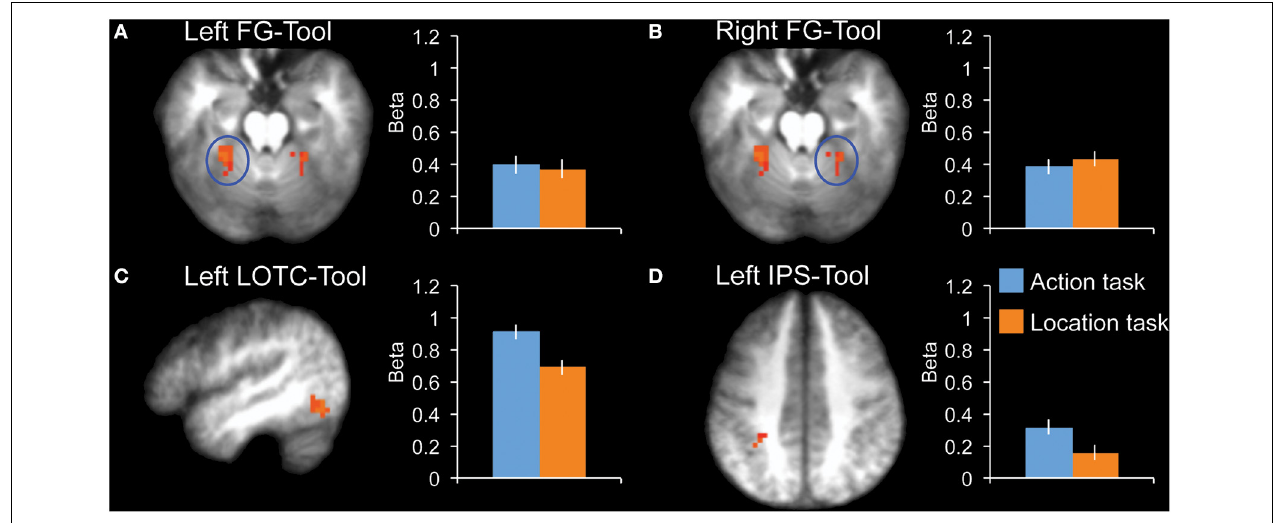
FIGURE 3 | fMRI results in tool-selective regions, localized by contrasting tools with animals. Bar graphs indicate mean activity (Beta weights) in the displayed ROIs during the action (blue) and location (orange) tasks of the main experiment. (A) Left FG-Tool